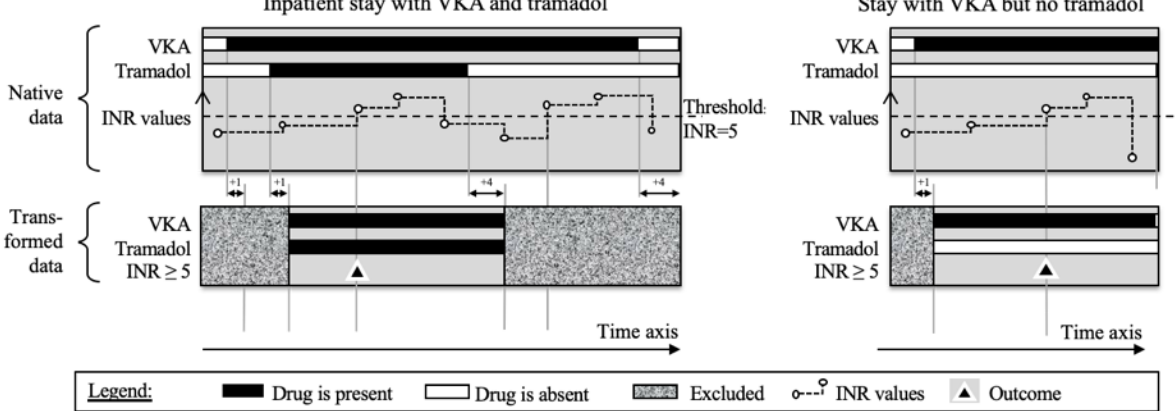
Figure 1. Data management: definitions of the inpatient stays included in the analysis. Time advances from left to right. INR: international normalized ratio. VKA: vitamin K